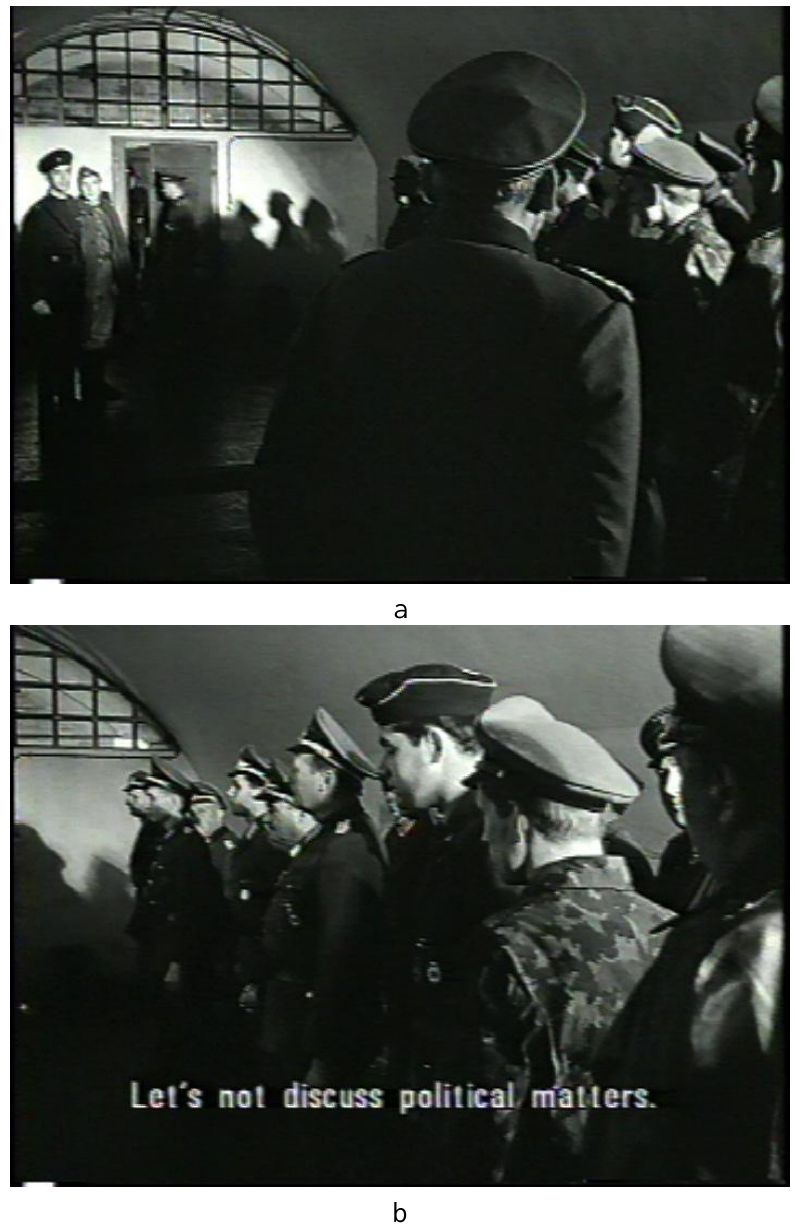
Figure 7. a. Representatives of the different elements in GDR society discuss the condition for future cooperation. b. below: The command of the SS officer, not to ―discuss political matters,‖ terminates the potential